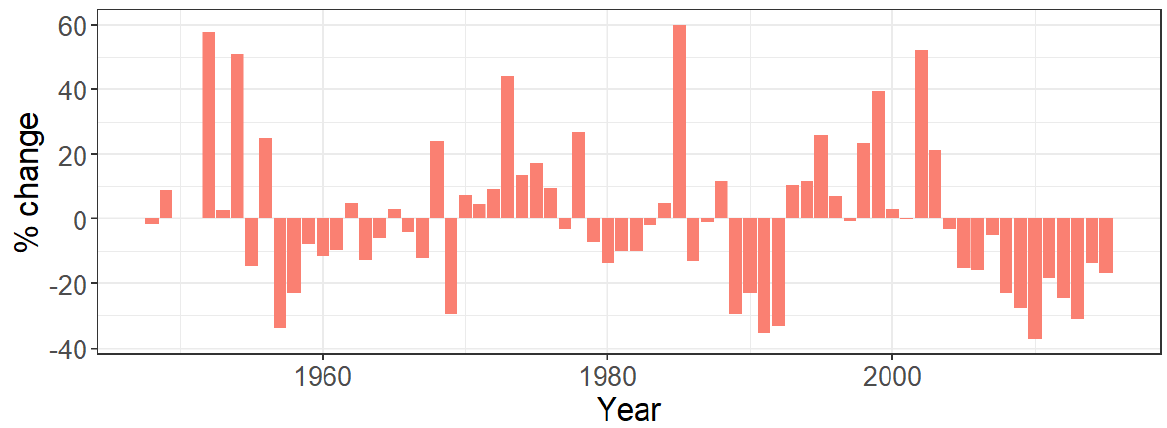
Figure 5. Deviation (%) of annual precipitation from the mean over 1948 to 2015 of 1469 mm in the study area.